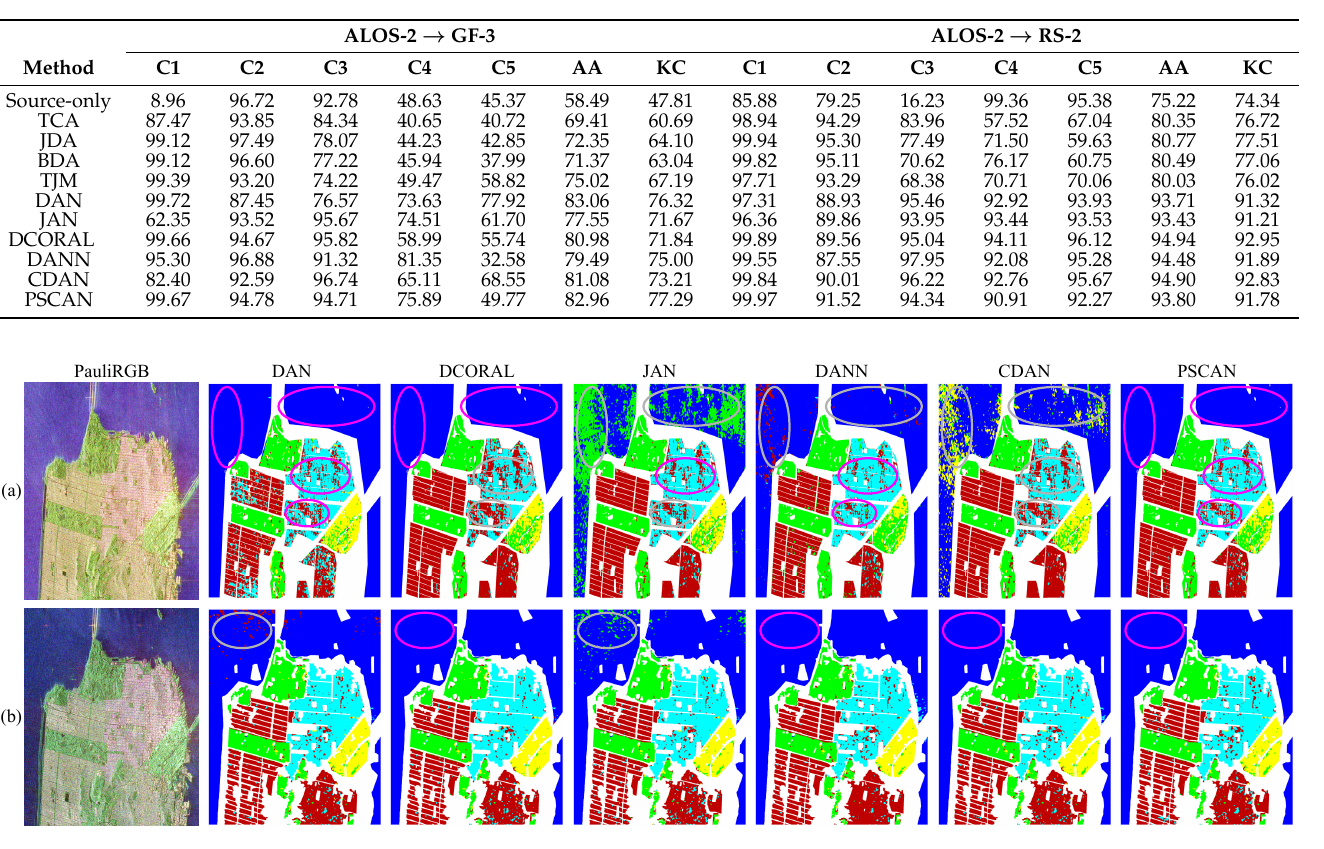
Figure 8. Comparison of the whole map classification results on the San Francisco area when the source domain is set to ALOS-2. The circles in pink and gray represent the correct and incorrect classification, respectively. ( a ) GF-3 as the target domain. ( b ) RS-2 as the target